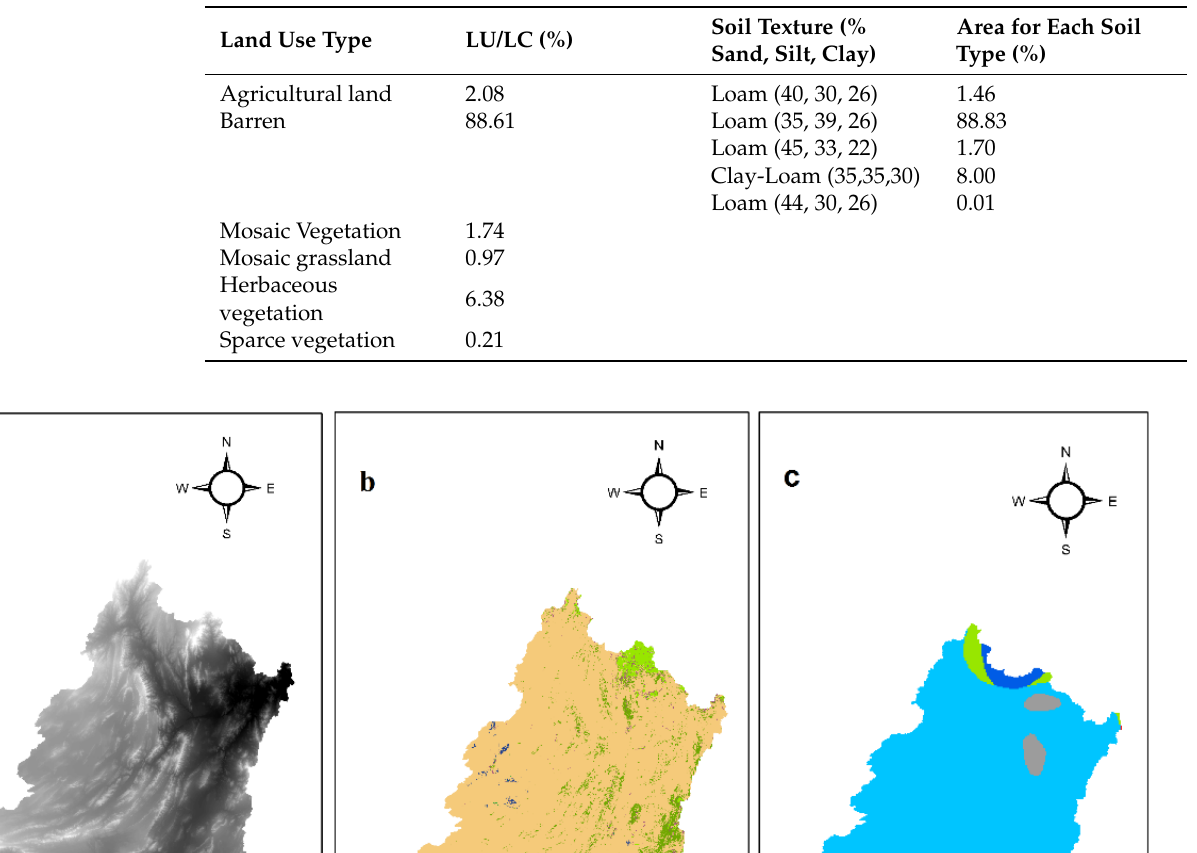
Table 3. Land use and soil type of study area.